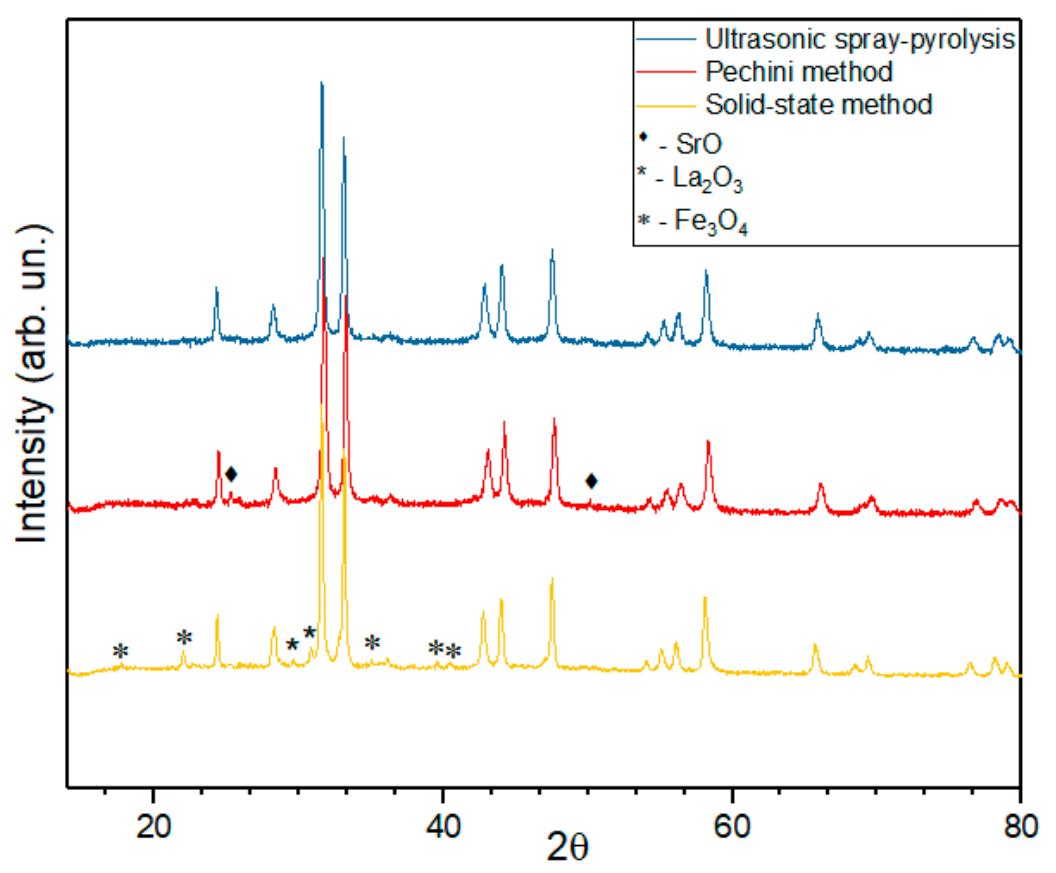
Figure 1. Diffractograms of LSNF prepared by the solid-state method, Pechini method and ultrasonic spray-pyrolysis.